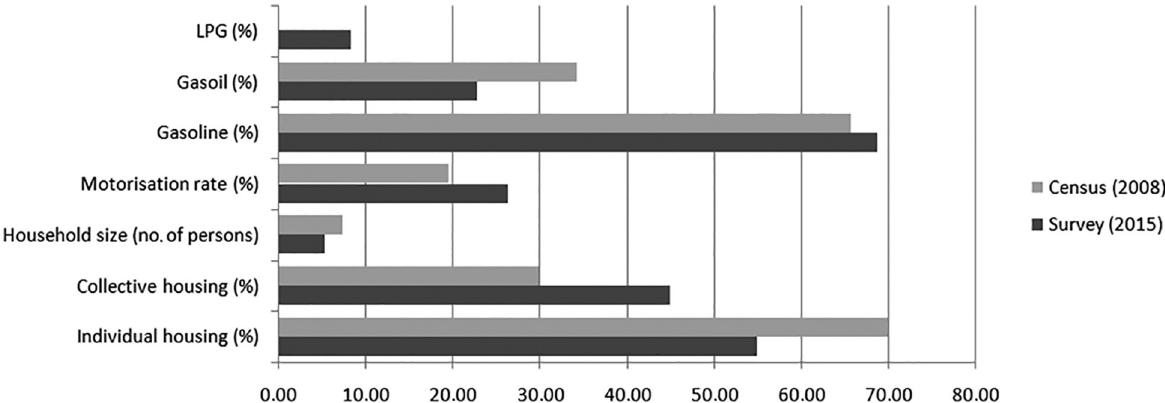
Fig. 4. Comparison between the survey and census